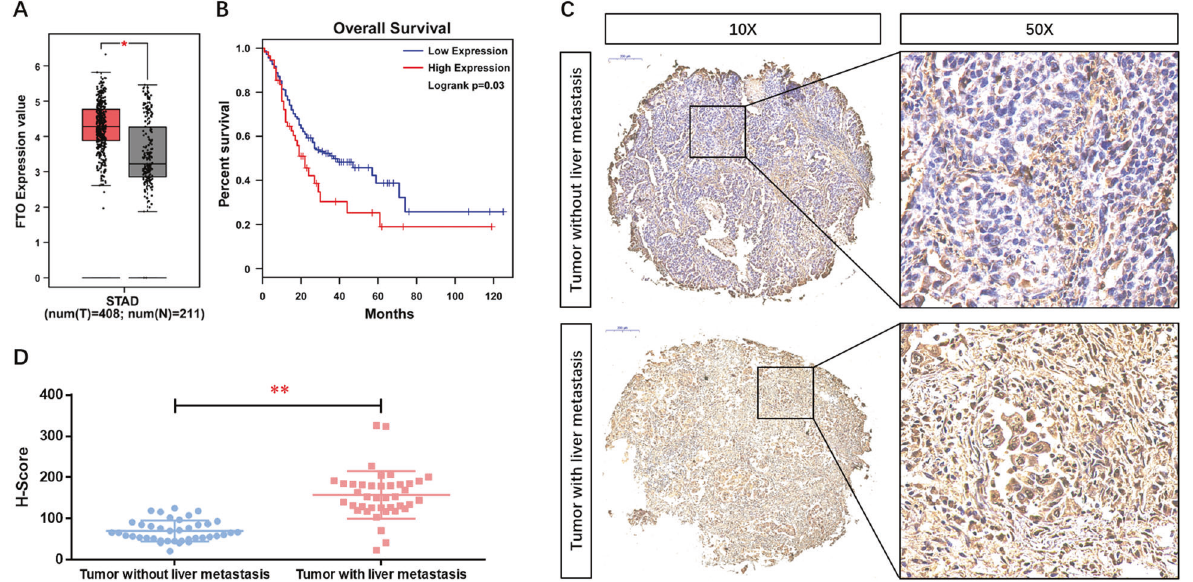
Fig. 1 FTO expression is up-regulated in GC tissues and its prognostic value in GC. A The expression of FTO at the mRNA level and B the prognostic value in gastric cancer tissues were analyzed in the clinical database GEPIA (http://gepia.cancer-pku.cn/). C The expression of FTO at the protein level in the GC tissue microarray consisting of 90 cases was analyzed using IHC. D Quantitative analysis was performed upon the IHC data. * p < 0.05, ** p < 0.01 compared with the indicated